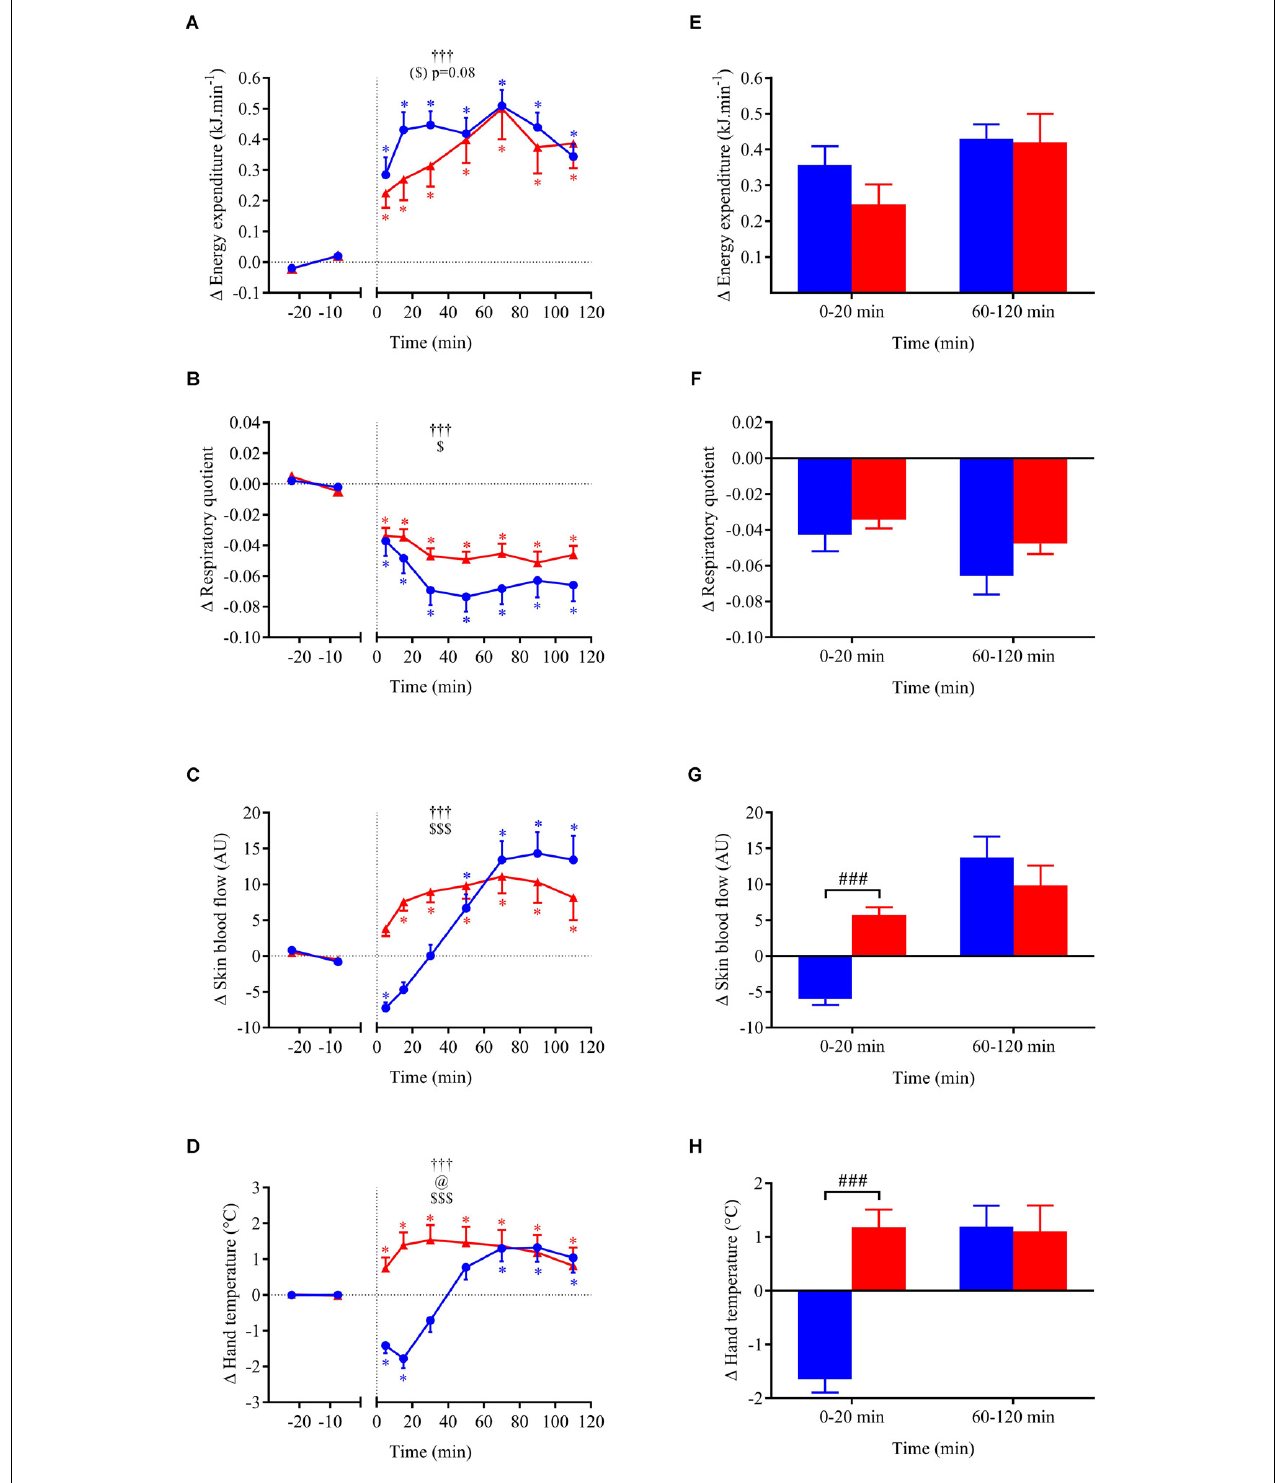
FIGURE 6 | (A–D) Time course of the changes in energy expenditure, respiratory quotient, skin blood flow, and hand skin temperature presented as delta (i.e., absolute changes relative to baseline levels). (E–H) Mean responses averaged over 0–20 and 60–120 min post-drink periods presented as delta (i.e., average over 0–20 and 60–120 min post-drink minus the average over the 30-min baseline period, respectively). Drinks: cold wine ( Symbols for ANOVA analysis: † , time effect; @, temperature effect; and $, time × temperature interaction effects. See legend of Figure 4 for level of significance.